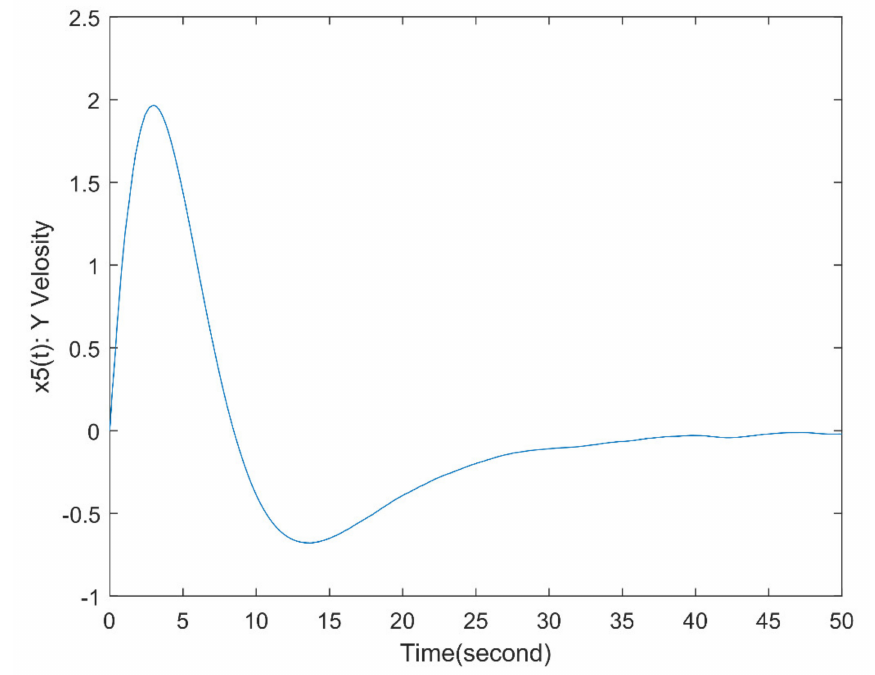
Figure 6. Response of state x 5 ( t ) .